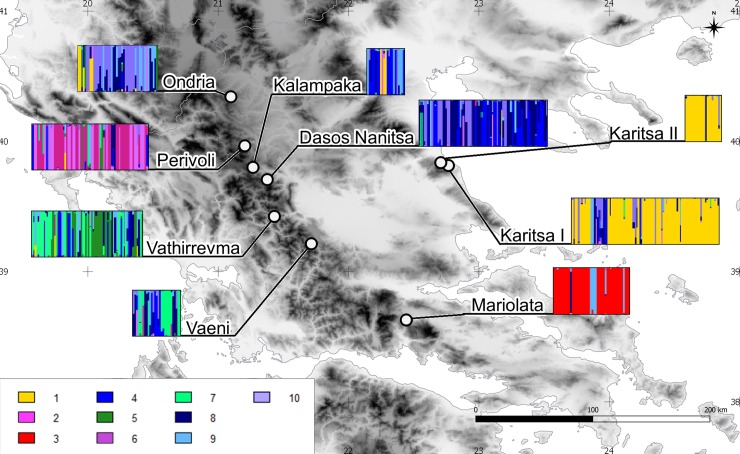
Genetic cluster inferred with DAPC analysis.